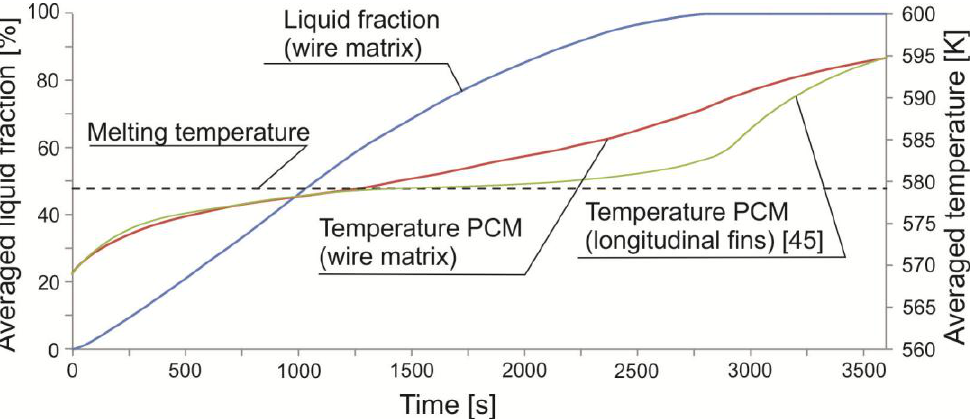
Figure 4. Chronological sequence of the volume averaged temperature and liquid fraction for the phase change material during the melting process.